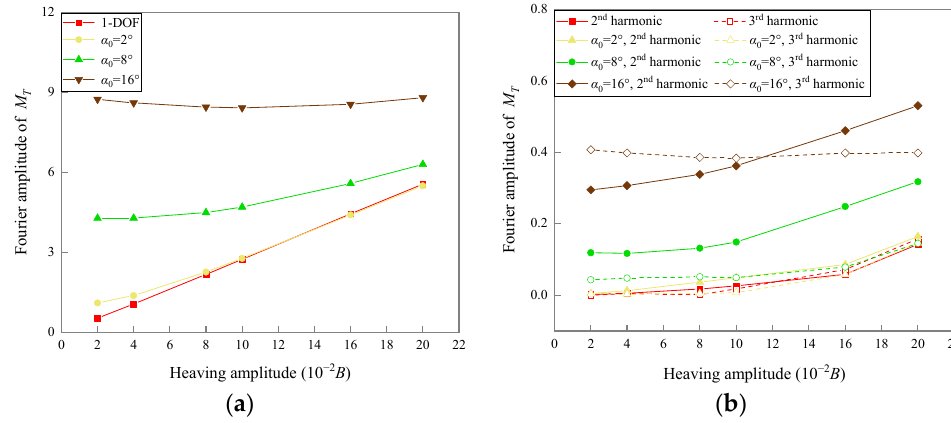
Figure 15. Variation in Fourier amplitude of aerodynamic moment with heaving amplitude. ( a ) The fundamental frequency; ( b ) Second harmonic and third harmonic.